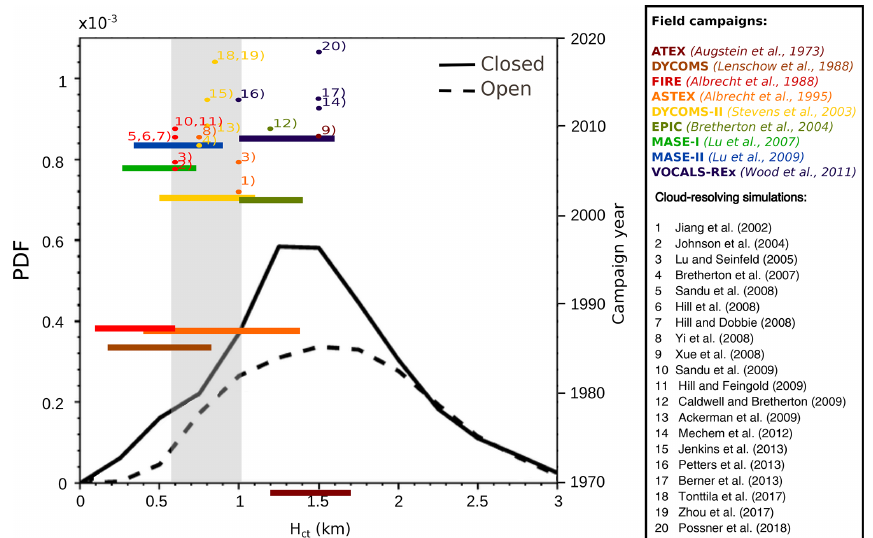
Figure 1. Probability density function (PDF) for closed, open-cell, and disorganised stratocumulus layers against cloud-top height. This figure is adapted from Fig. 10 in Muhlbauer et al. (2014). Coloured bars denote the range of cloud-top heights sampled during each campaign listed in the legend. LES and cloud-resolving studies investigating aerosol–cloud–radiation interactions are colour-coded by the campaigns they are based on (with the exception of model study 8, which is based on an idealised profile). Grey shading denotes narrow BL-depth interval within which 75% of all modelling studies reside. Future analyses of past campaigns summarised in Zuidema et al. (2016) will likely increase the data points sampled in deeper BLs. References: Jiang et al. (2002), Johnson et al. (2004), Lu and Seinfeld (2005), Bretherton et al. (2007), Sandu et al. (2008), Hill et al. (2008), Hill and Dobbie (2008), Yi et al. (2008), Xue et al. (2008), Caldwell and Bretherton (2009), Ackerman et al. (2009), Sandu et al. (2009), Hill and Feingold (2009), Mechem et al. (2012), Jenkins et al. (2013), Petters et al. (2013), Berner et al. (2013), Tonttila et al. (2017), Zhou et al. (2017), Possner et al. (2018), Augstein et al. (1973), Lenschow et al. (1988), Albrecht et al. (1988, 1995), Stevens et al. (2003), Bretherton et al. (2004), Lu et al. (2007, 2009), and Wood et al.